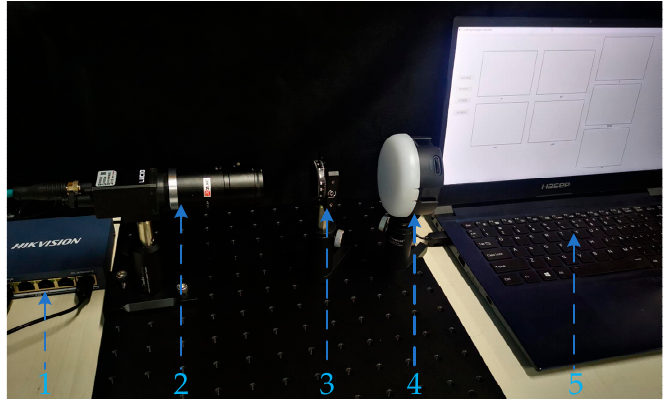
Figure 7. Response test platform for polarized pixels.